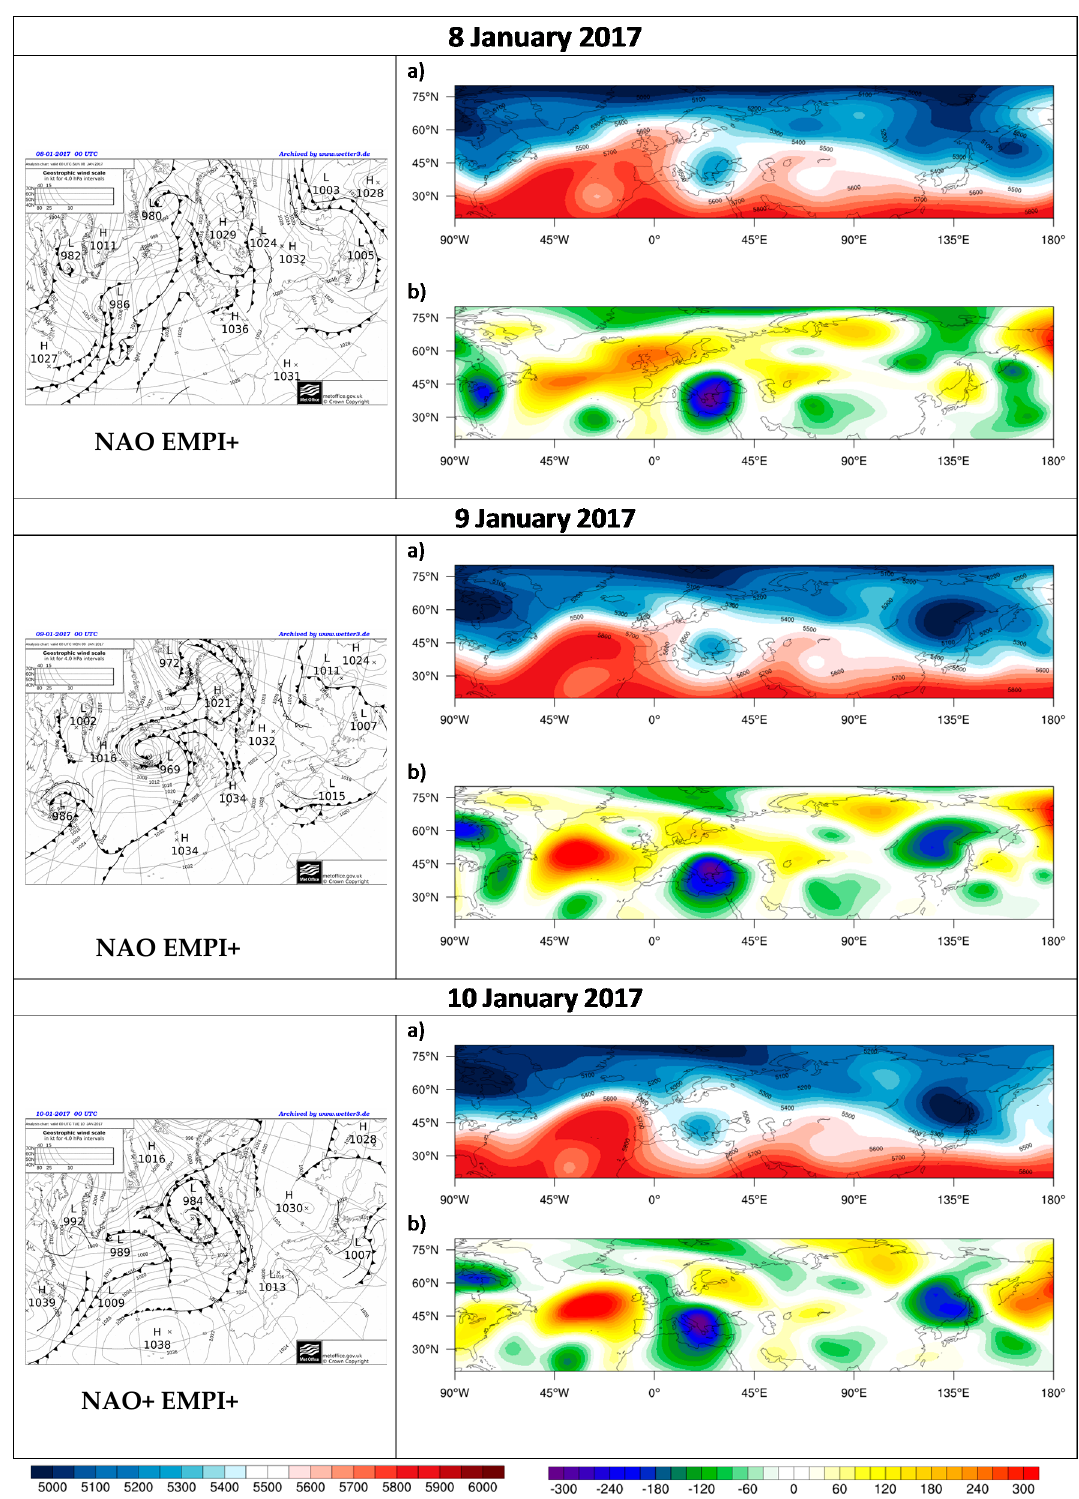
Figure 6. The synoptic pattern for the P-0 stage (8–10 January 2017) and the temporal variation of the NAO and the EMP. First column: SLP (Met Office; www.wetter3.de); second column: ( a ) geopotential height of 500 hPa and ( b ) anomalies of geopotential heights at 500 hPa level.